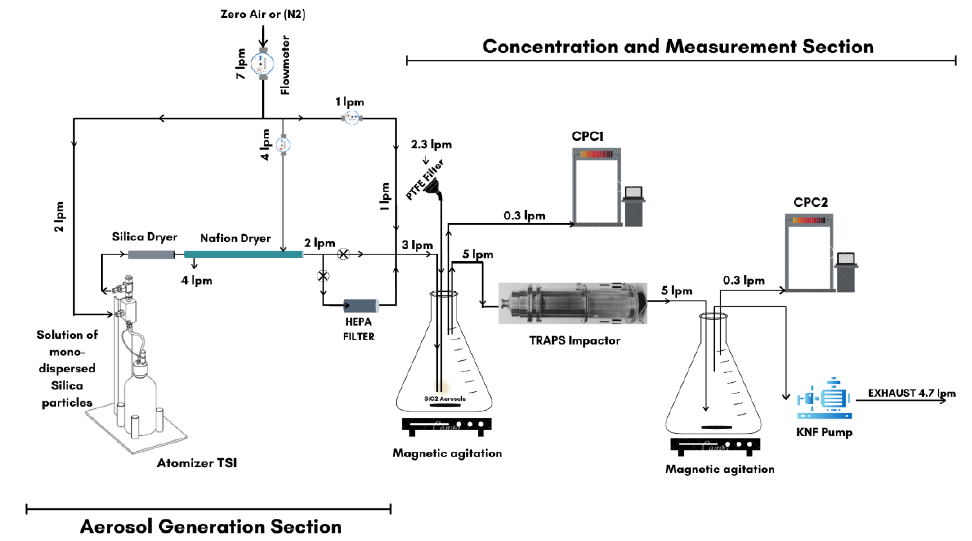
Figure 2. Schematic view of the experimental setup for determining the fine stage collection effi- ciency using nebulized monodisperse silica spheres. using nebulized monodisperse silica